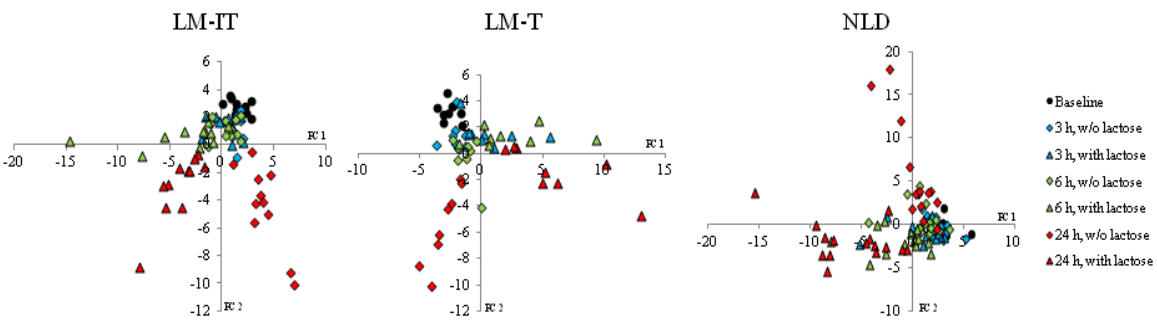
Figure 4. Results of multivariate analysis of fecal metabolite profiles. Relative indices of the metabolites detected in the fecal samples collected by LM-IT, LM-T and NLD at baseline and after incubation for 3 h, 6 h and 24 h with and without 6.25 mg of lactose were used for a supervised clustering analysis by a partial least squares-discriminant analysis. The resulting scores for principal components (PC) 1 and 2 are shown. Corresponding loading plots are presented in supplementary information. NLD: normal lactose digestion; LM-IT: lactose malabsorption with abdominal complaints; LM-T: lactose malabsorption with without abdominal complaints.